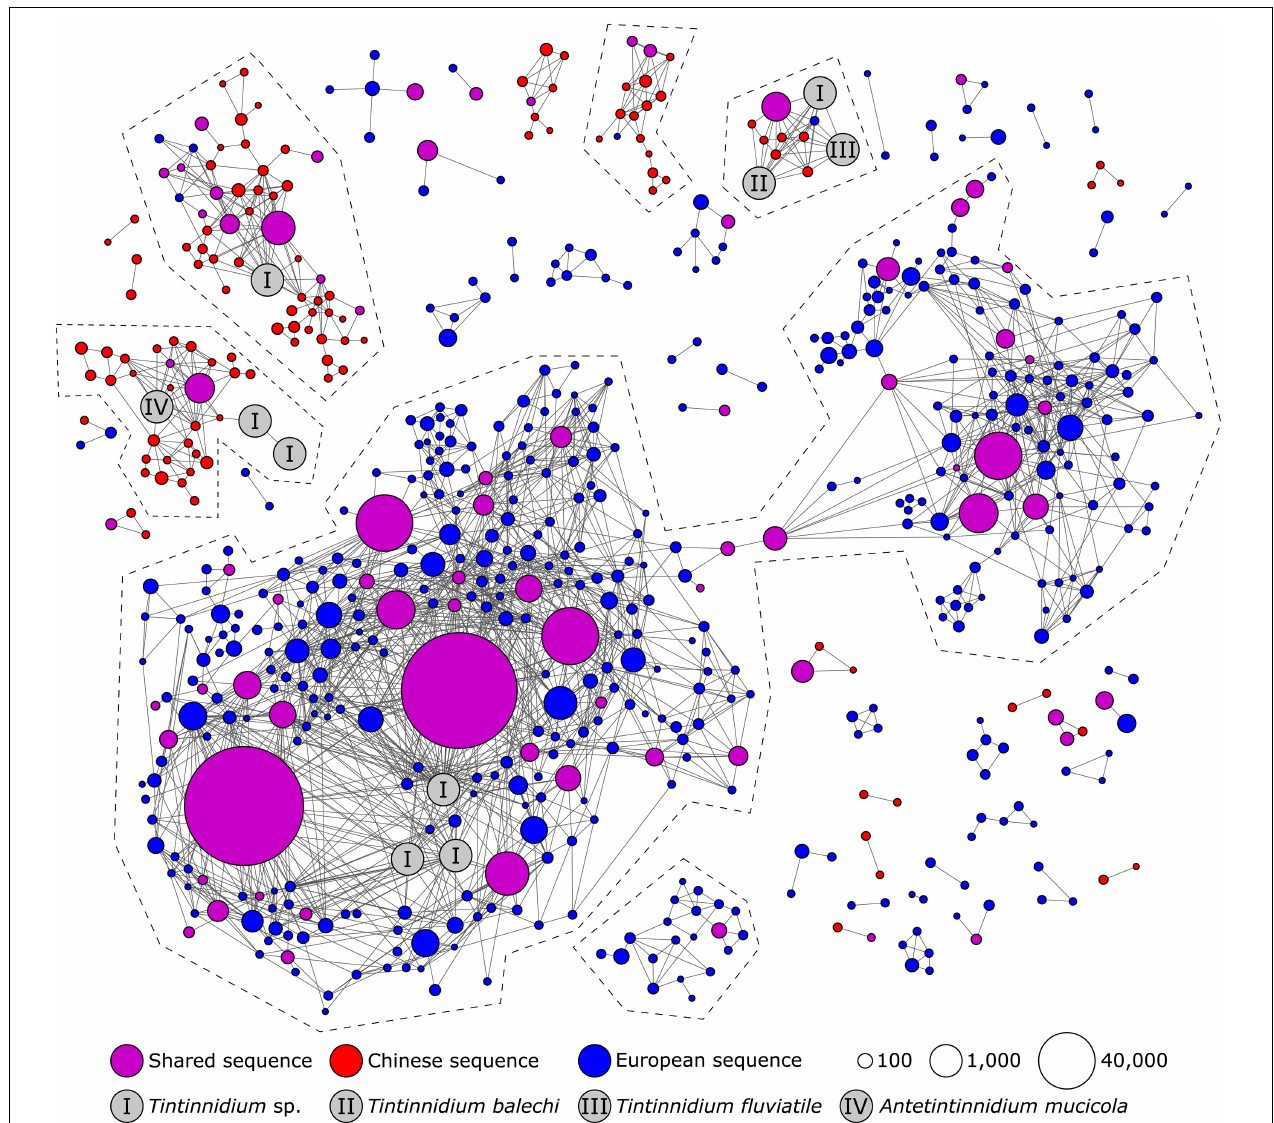
FIGURE 6 | Second-level clustering of the representative amplicons of Swarm OTUs detected in the present study and reference sequences from the PR 2 database assigned to the Tintinnidiidae tintinnids. At a threshold of 98.5%, the OTUs grouped into six larger network sequence clusters (NSCs), two of which did not contain any reference sequences and another two NSCs which contained unidentified congeneric reference sequences ( Tintinnidium sp.). The circle sizes correspond to the read numbers of the representative amplicon sequences of the Swarm OTUs. NSCs which indicate potential species are framed by a dashed